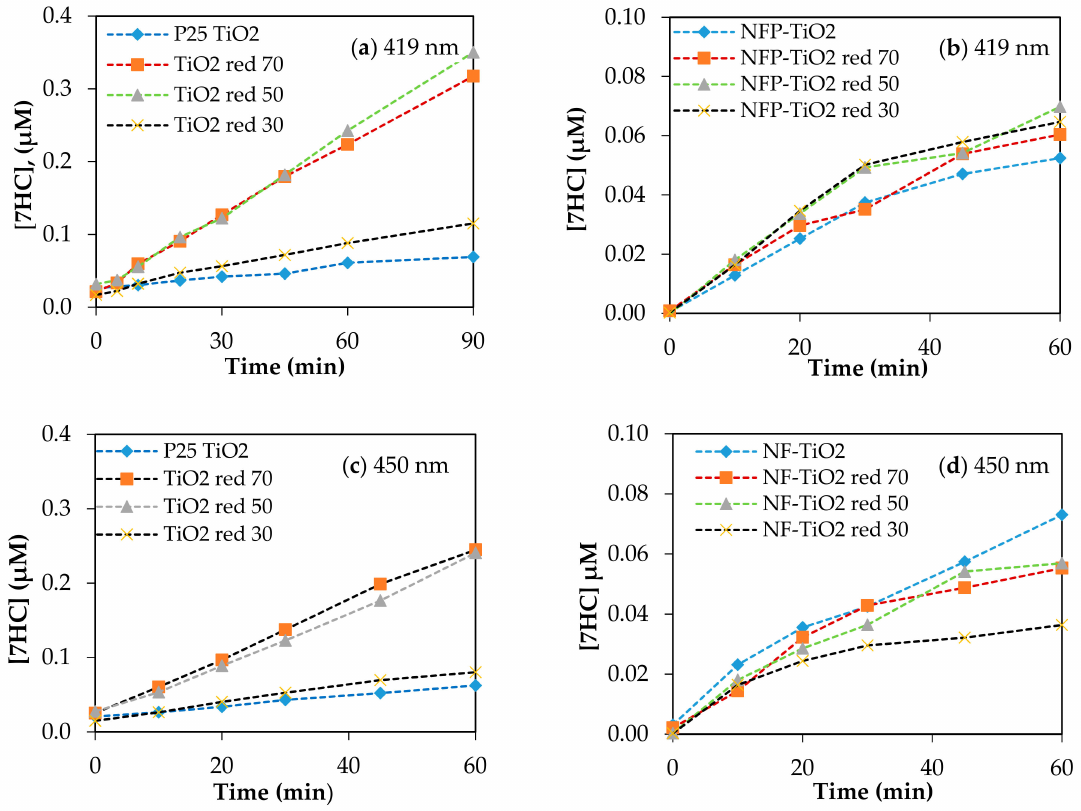
Figure 8. Production of 7HC using various TiO 2 upon irradiation at visible light ( a , b ) 419 nm; ( c , d ) 450 nm. Catalyst loading was 0.10g / L; [COU] = 125 µ